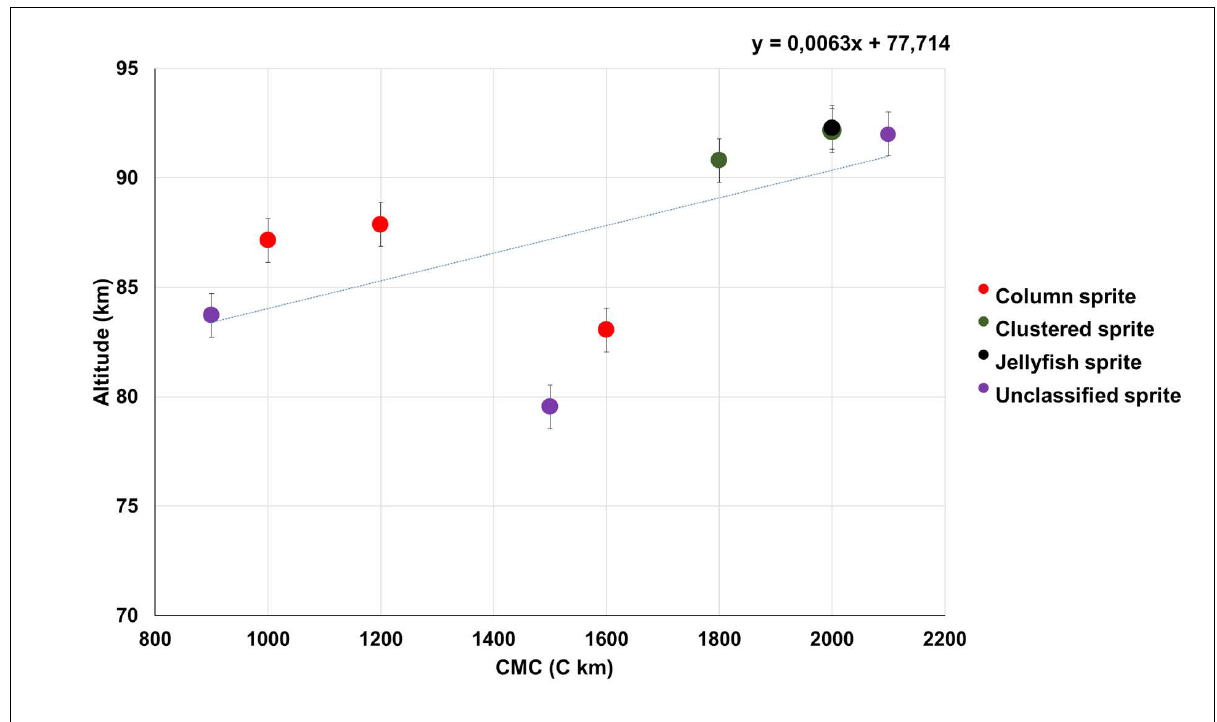
Figure 5: The relationship between charge moment change (CMC) and the top altitude of